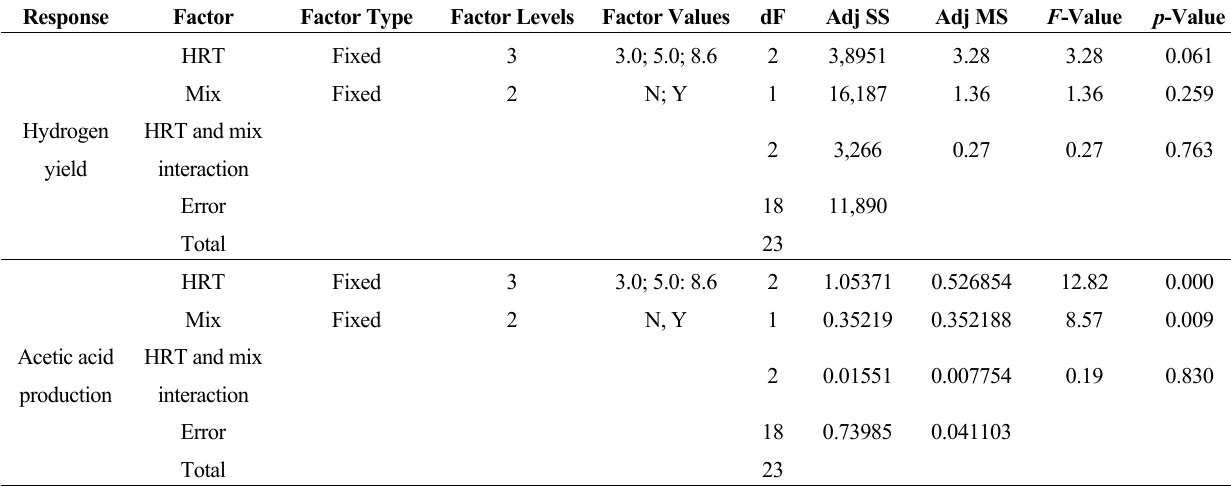
Table 3. Summary of two-way analysis of variance (ANOVA) for the effects of hydraulic retention time (HRT) and fruit mixing (Mix) on hydrogen yield and acetic acid production.